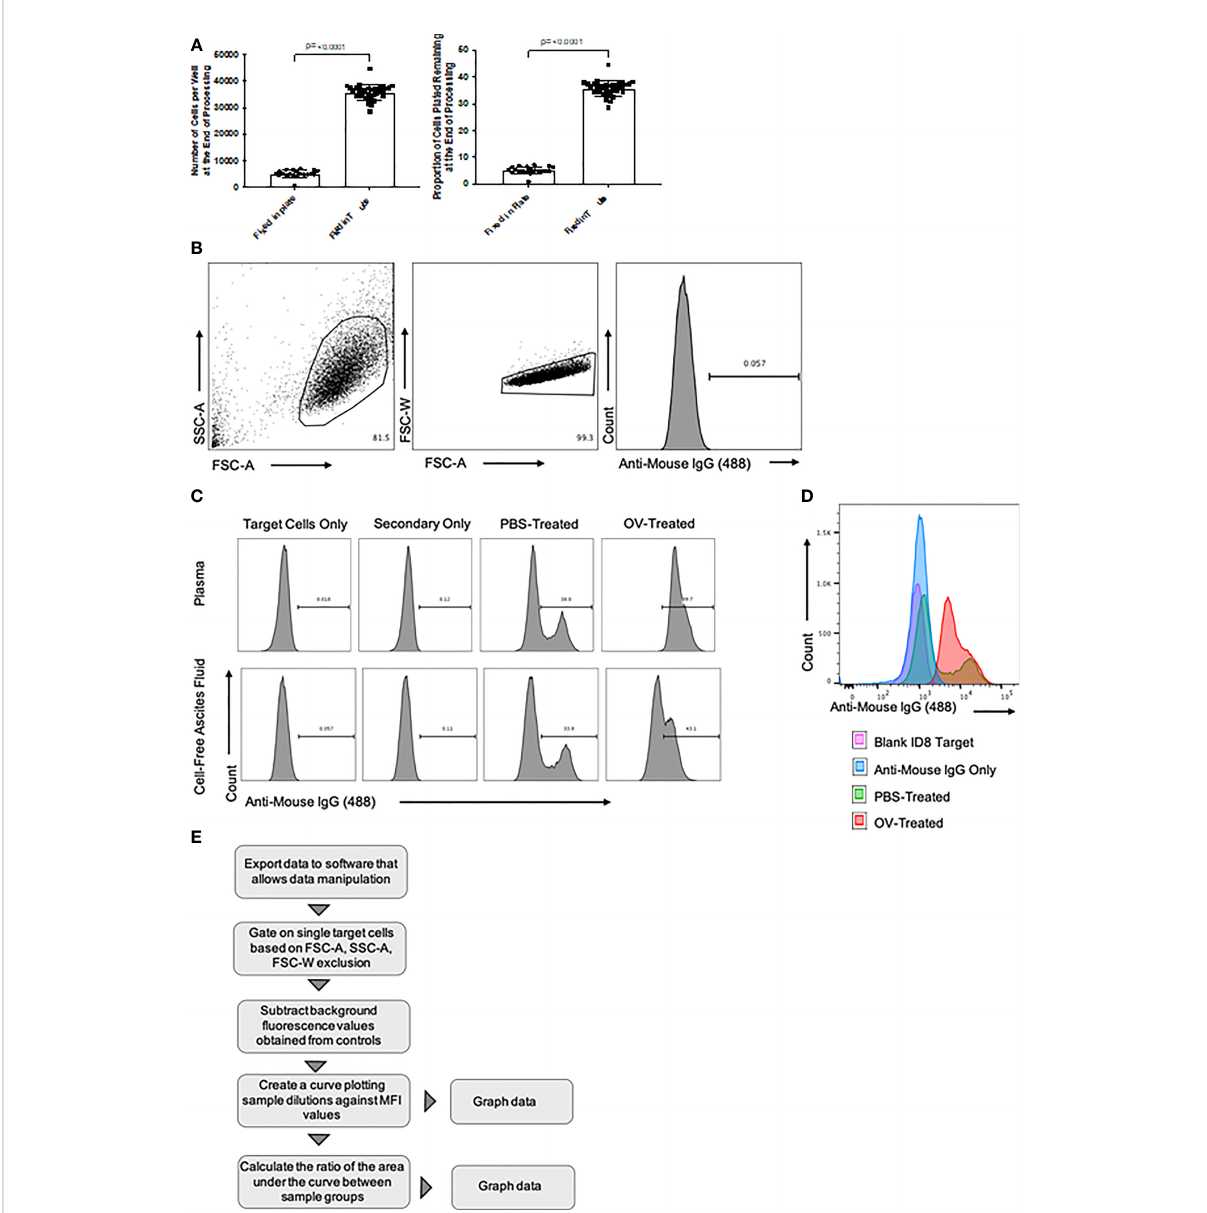
FIGURE 2 Overview of fl ow cytometry optimization, gating strategy, and data analysis. (A) Target cell recovery following fi xation of cells in fl uorescence- activated cell sorting (FACS) tubes versus 96-well U-bottom plates. The number of cells recovered, and the proportion of cells remaining following processing, at the time of target-directed antibody detection are shown. Statistical analysis was conducted using a two-tailed Student ’ s t-test. Statistical signi fi cance was de fi ned as P-values less than or equal to 0.05. (B) Targeted ID8 tumor cells were gated based on forward scatter area (FSC-A) versus side scatter area (SSC-A) characteristics (left panel). Doublets were then removed after gating FSC-A versus forward scatter width (FSC-W) (middle panel). Histograms were generated by plotting the cell count on the y-axis versus anti-mouse IgG1-Alexa Fluor 488 secondary antibody-mediated fl uorescence on the x-axis (right panel). (C) Generated histograms representative of tumor-associated antibodies binding to target ID8 murine ovarian carcinoma cells in either plasma (top panels) or cell-free ascites fl uid (bottom panels) samples diluted 1/100. These samples were collected from ID8 tumor-bearing mice 21 days after treatment with either phosphate-buffered saline (PBS) or an oncolytic virus (OV). Histograms generated from intra-assay target cell and secondary antibody only controls identi fi ed background fl uorescence. Tumor-associated antibody binding was represented as a function of positive anti-mouse IgG1 Alexa Fluor 488 conjugated secondary antibody signals from target ID8 tumor cells incubated with plasma from either PBS or OV-treated ID8 tumor-bearing mice. (D) Representative histogram overlay comparing an anti-mouse IgG1 Alexa Fluor 488 signal from targeted ID8 tumor cells treated with 1% BSA alone (pink), anti-mouse IgG Alexa Fluor 488 alone (blue), or cell-free ascites fl uid diluted 1/100 from PBS-treated (green) or OV-treated (red) ID8 tumor-bearing mice and then stained with anti-mouse IgG1 Alexa Fluor 488. (E) Data analysis work fl ow summary, from data export to graphical representation. MFI, mean fl uorescence